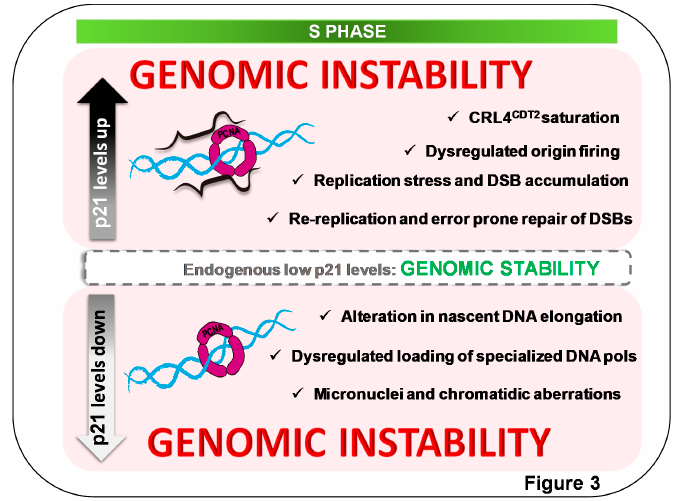
Figure 3. Alterations of endogenous p21 levels in S phase cause genomic instability. Endogenous p21 S normal levels are within the segmented gray box, interacting with PCNA in replication factories